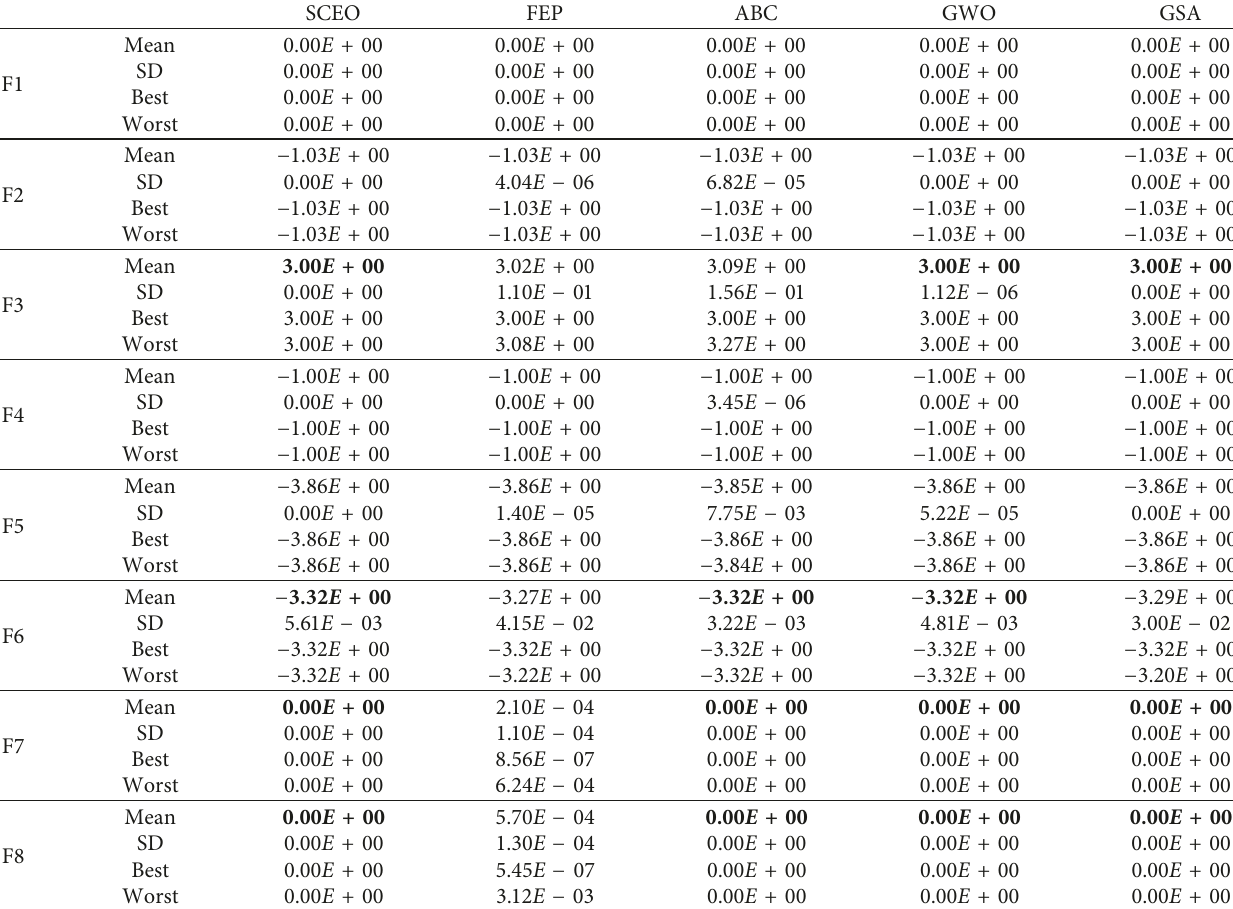
Table 6: Comparison with FEP [15], ABC [29], GWO [7], and GSA [30].